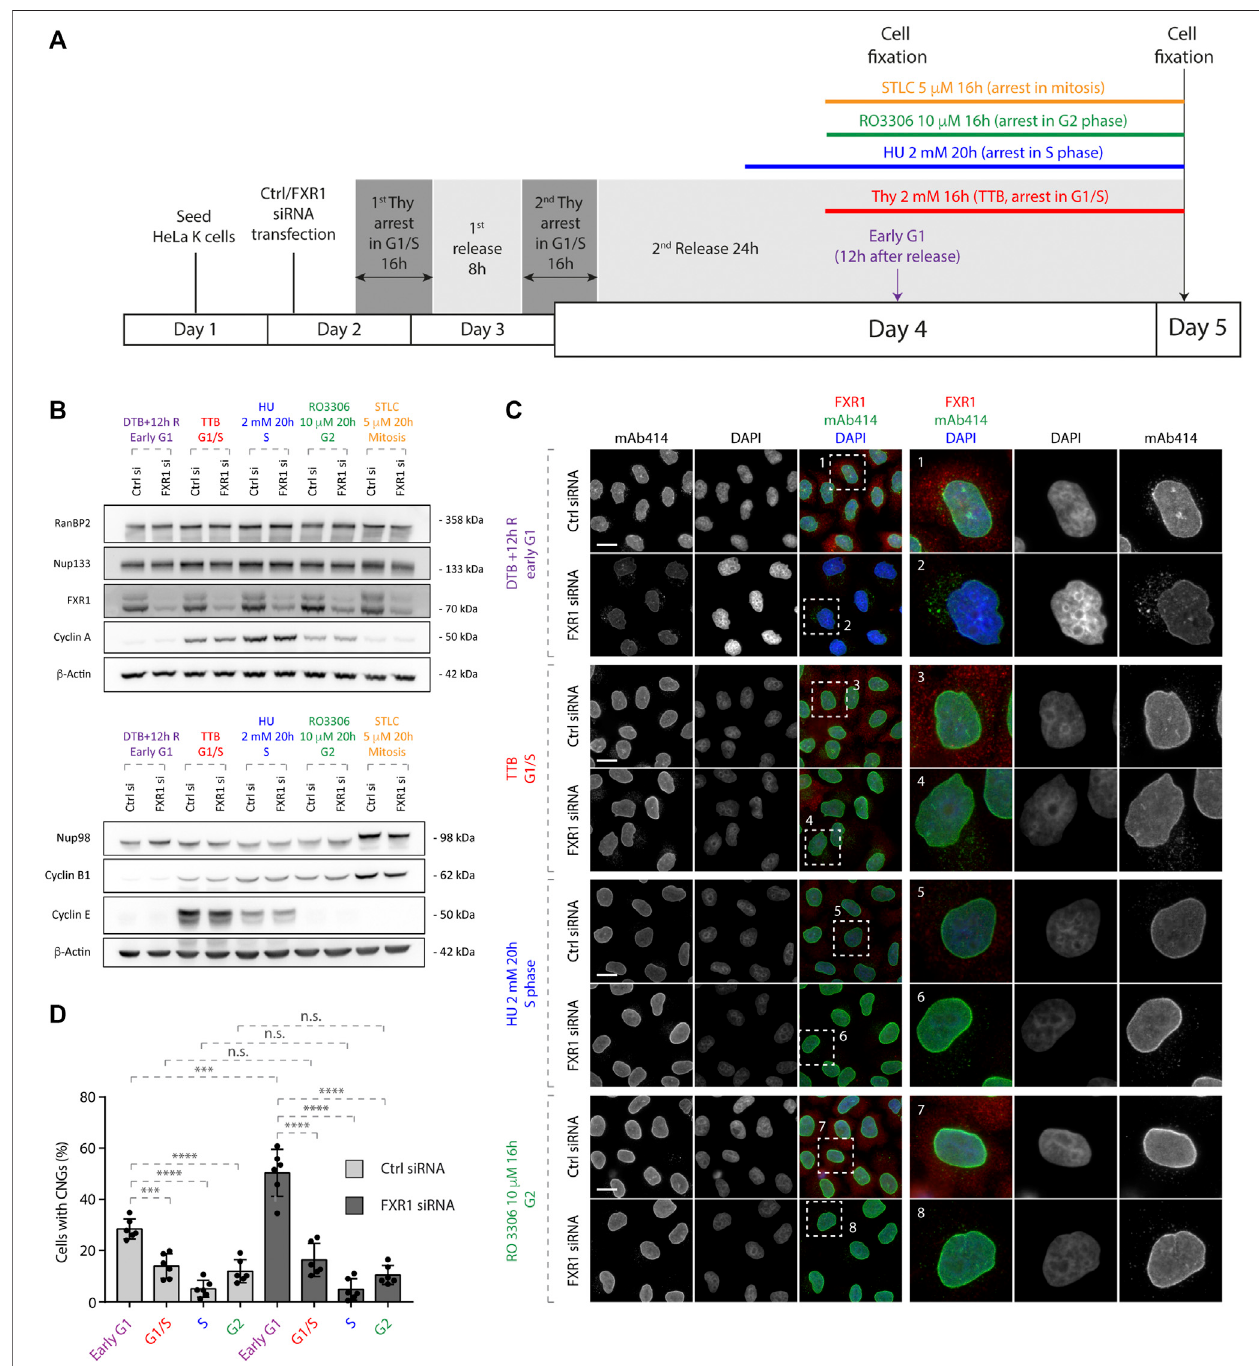
FIGURE 3 | Nup localization is regulated by FXR1 in a cell cycle – speci fi c manner. (A) Scheme of the experimental setup. HeLa K cells were seeded on coverslips, treated with the indicated siRNAs, synchronized in different cell cycle stages by different treatments: double thymidine block, and released for 12 h (DTB+12 h R, early G1); triple thymidine block (TTB, arrest in G1/S transition); incubation in 2 mM hydroxyurea (HU) for 20 h (arrest in the S phase); incubation in 10 µM RO3306 (CDK1 inhibitor) for 16 h (arrest in the G2 phase); and incubation in 5 µM STLC for 16 h (arrest in early mitosis). Subsequently, the cells were analyzed by Western blotting (B) and immuno fl uorescence microscopy (C, D) . (B) Whole cell lysates from cells treated as in (A) were analyzed by Western blot. (C, D) Cells treated as in (A) were analyzed by immuno fl uorescence microscopy (C) and the percentage of cells with cytoplasmic nucleoporin granules (CNGs) was quanti fi ed. (D) 9,800 cells were analyzed (mean ± SD, *** p < 0.001; **** p < 0.0001; n.s. (cid:1) non-signi fi cant, N (cid:1) 6). The magni fi ed framed regions are shown in the corresponding numbered panels. Data information: scale bars are 5 μ m. Statistical signi fi cance was assessed by one-way ANOVA test with Sidak ’ s correction.